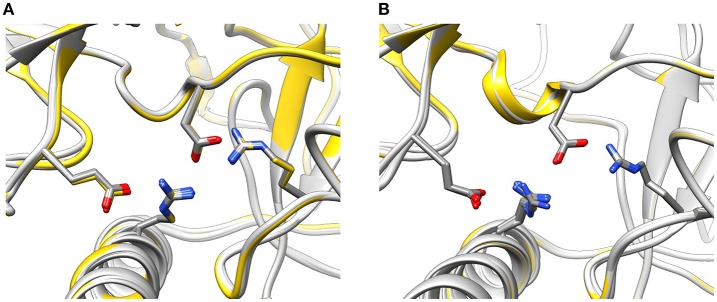
Configuration of the interaction network D61—R417—E40—R298 in mutant NTRs. (A) Wild type (yellow) and mutant (light gray) NTR models in the closed (A) and open state (B).